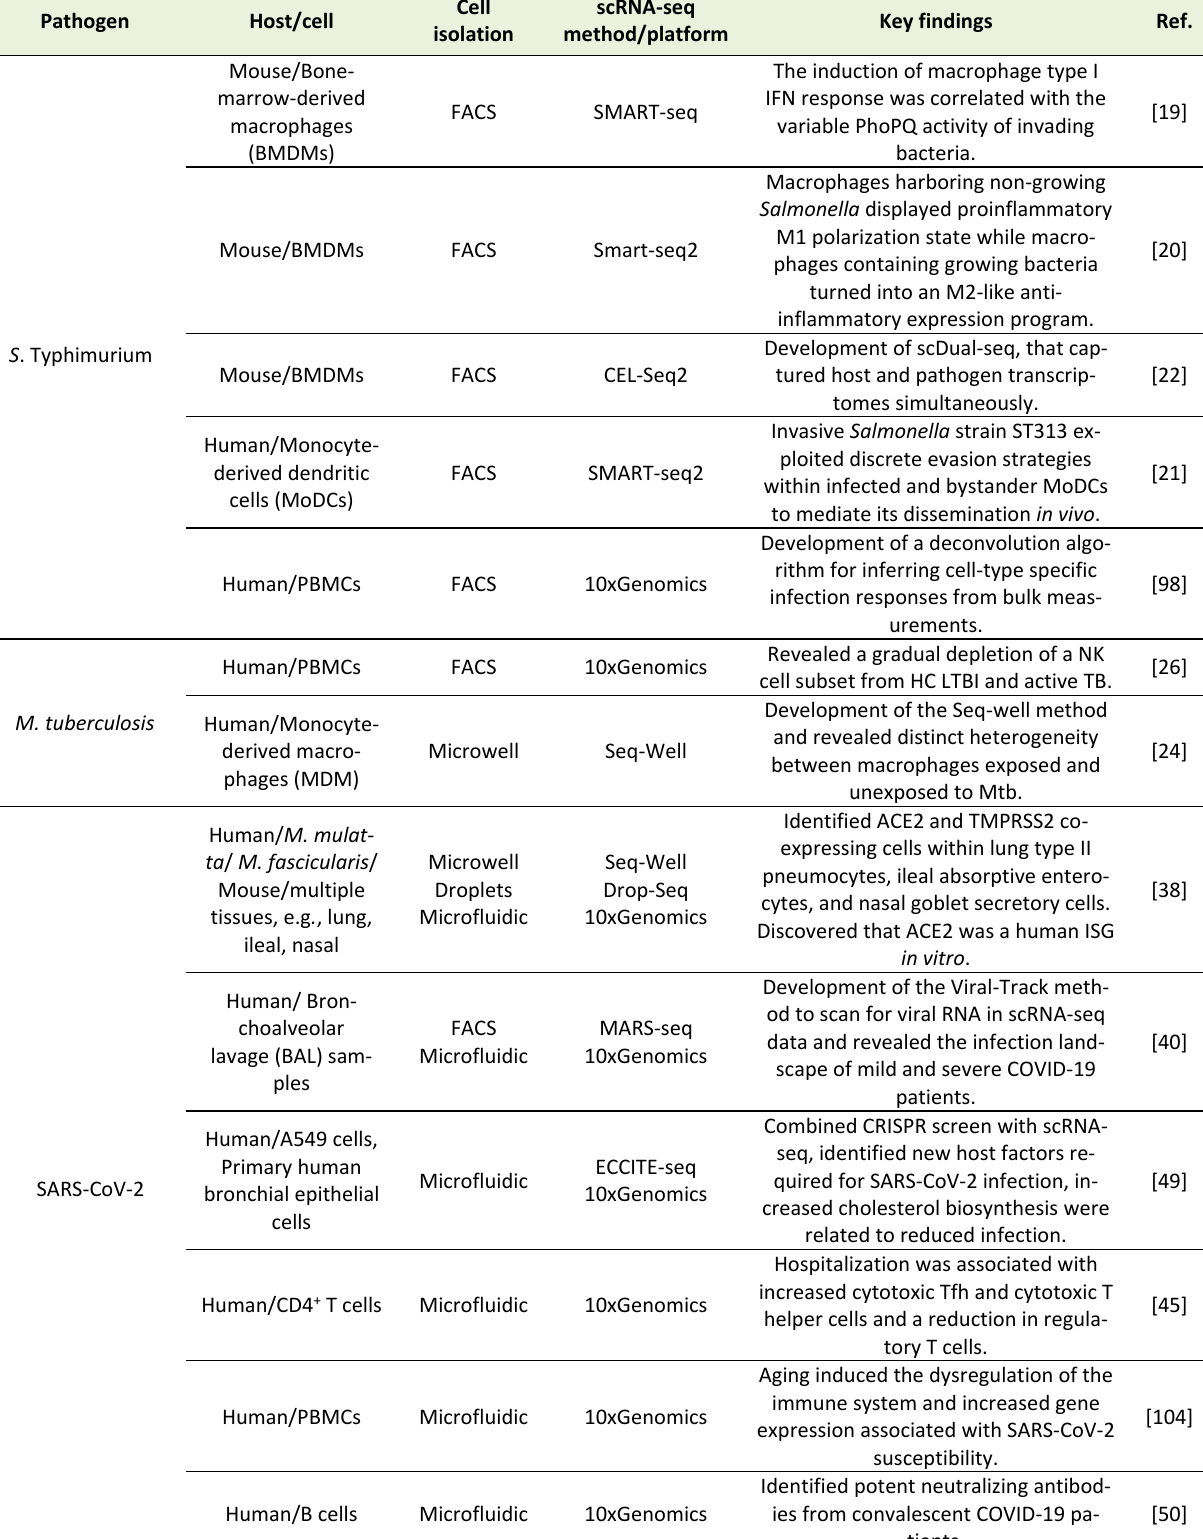
TABLE 1. The applications of scRNA-seq in